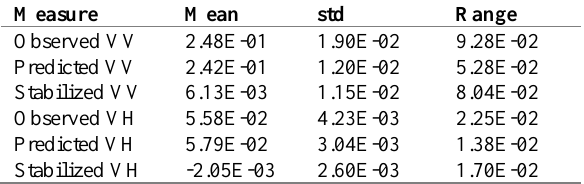
Table 2. Results of the stabilization of the validation dataset (time-series from 10/2018 to 10/2019). Units are linear. Overall, there is a reduction of 39% of the variability of both VV and VH polarizations, in terms of standard deviation.